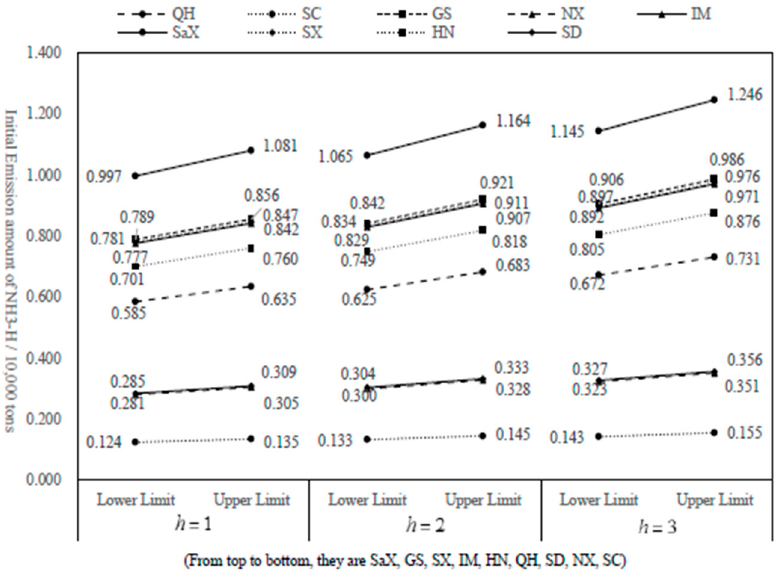
Figure 3. Allocation and variation trend of NH 3 -N in nine regions in 2030 under different scenarios.